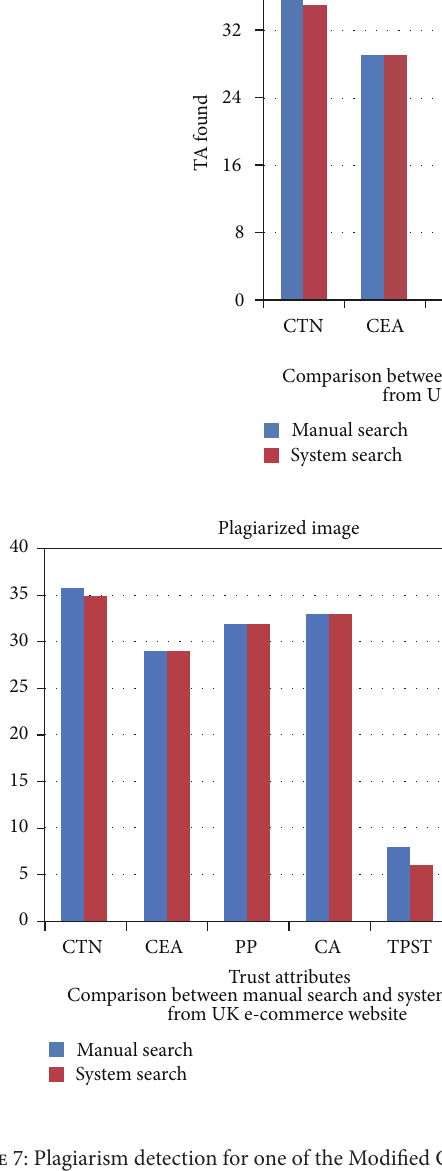
plagiarism detection including direct copy of all data or part of data are underscored. Plagiarism which is